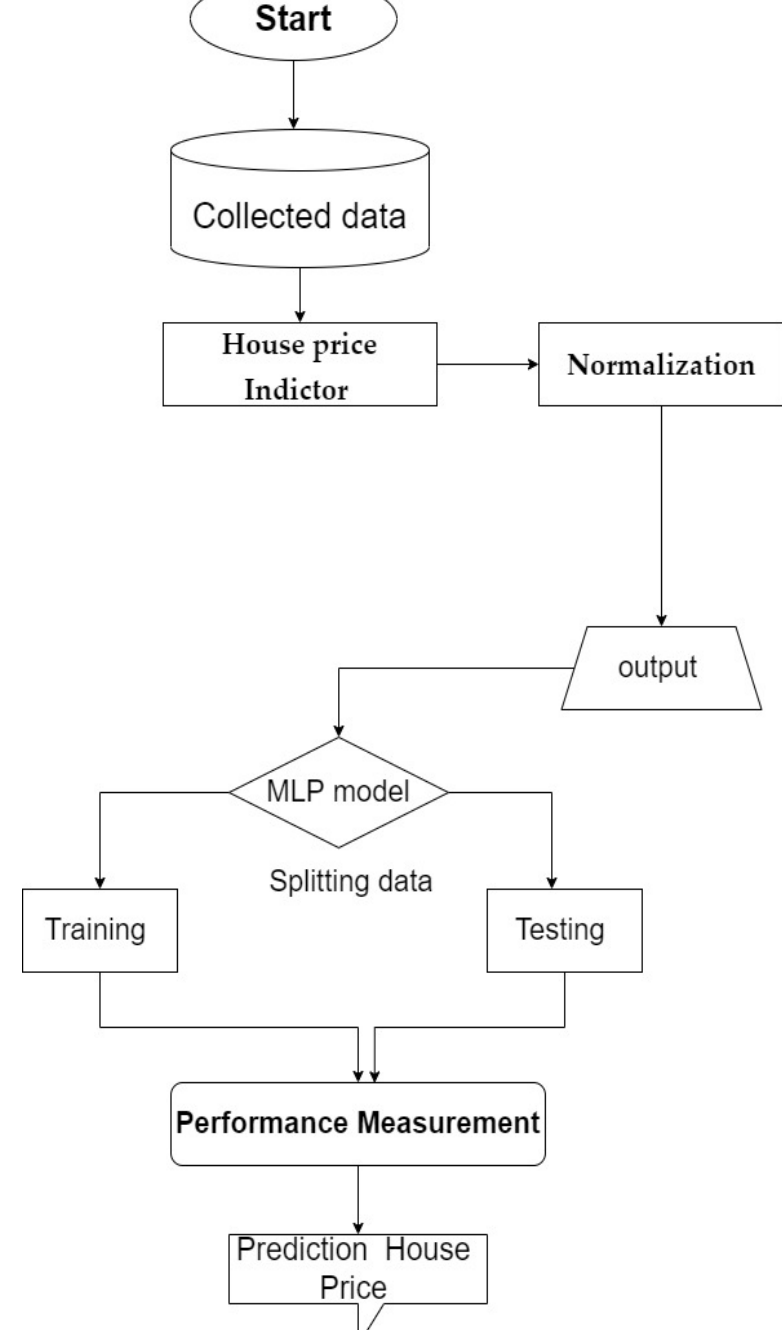
Figure 2. Block diagram of the ANN model for predicting housing